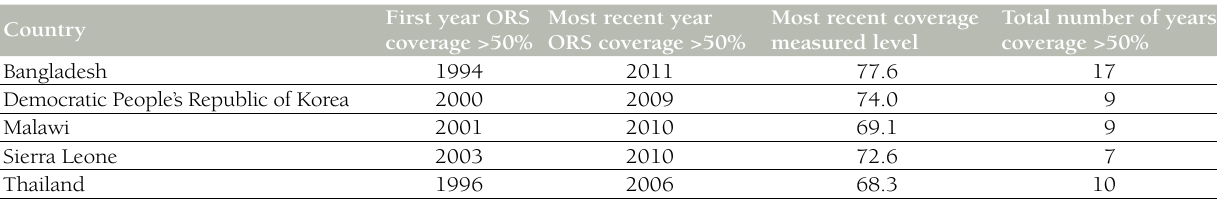
Table 1. Countries meeting the criteria for “sustained” success